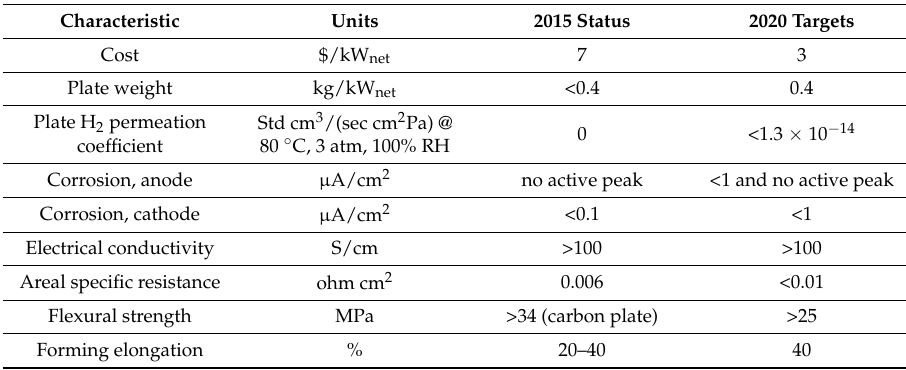
Table 1. Department of Energy DOE targets for bipolar